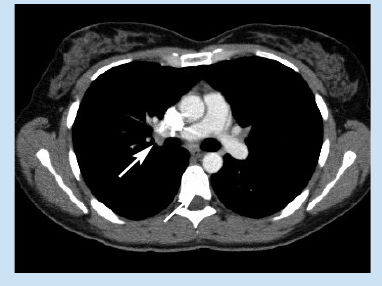
vein.Fig. 2. Portion of the right superior pulmonary vein appearing as a lymph node on axial